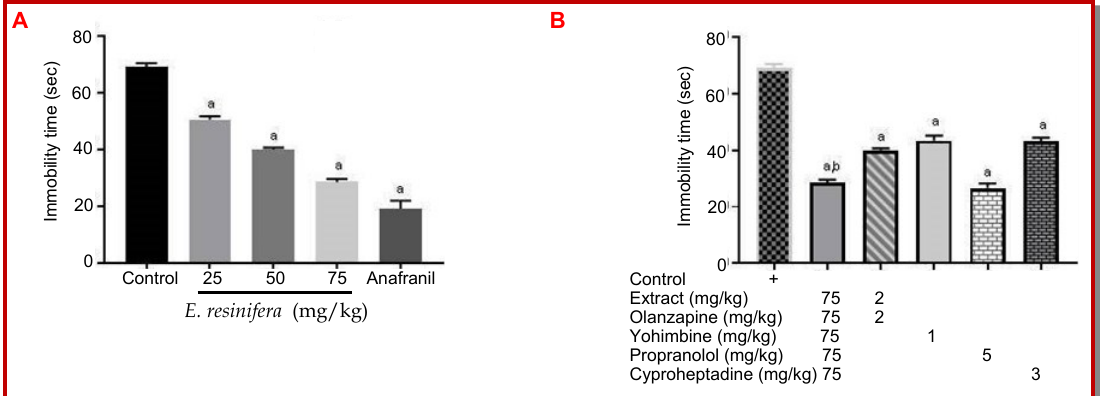
Figure 4: Antidepressant-like effect of E. resinifera in forced swimming test (A), and effect of the pretreatment with olanzapine, yohimibine, diazepam, propranolol, cyproheptadine (B) on the aqueous latex extract from E. resinifera -induced decrease in immo- bility time in the animals forced swimming test, (n=6 per group). Data were expressed as mean ± SEM, where superscript ‘a’ in di- cate p<0.05 significant difference between control group and different treated groups, b indicate p<0.05 significant difference be- tween groups. One- way ANOVA followed by Tukey’s post hoc